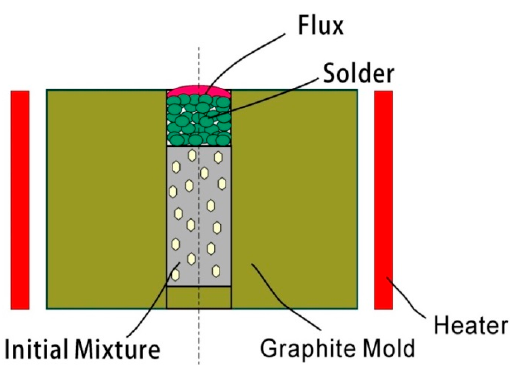
Figure 1. Schematic diagram of pressureless infiltration. Sample size: φ 8 mm × 32 mm.